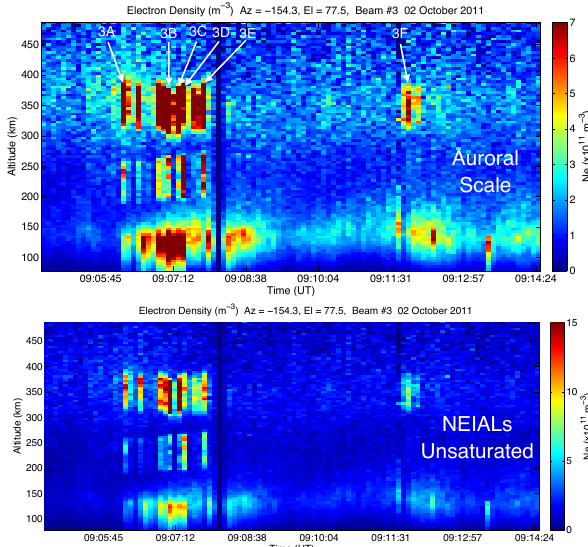
Figure 8. Event 3: top: PFISR electron density profiles, covering a time period of about 10min with dynamic, highly structured and flickering aurora in zenith. The strong NEIAL returns can be seen in two limited altitude ranges, mostly between 200 and 250km and between 300 and 400km. The times marked 3A–3F are the times of the NEIAL spectra shown in Fig. 9. Bottom: same time period with intensity scale set so the NEIALs are not